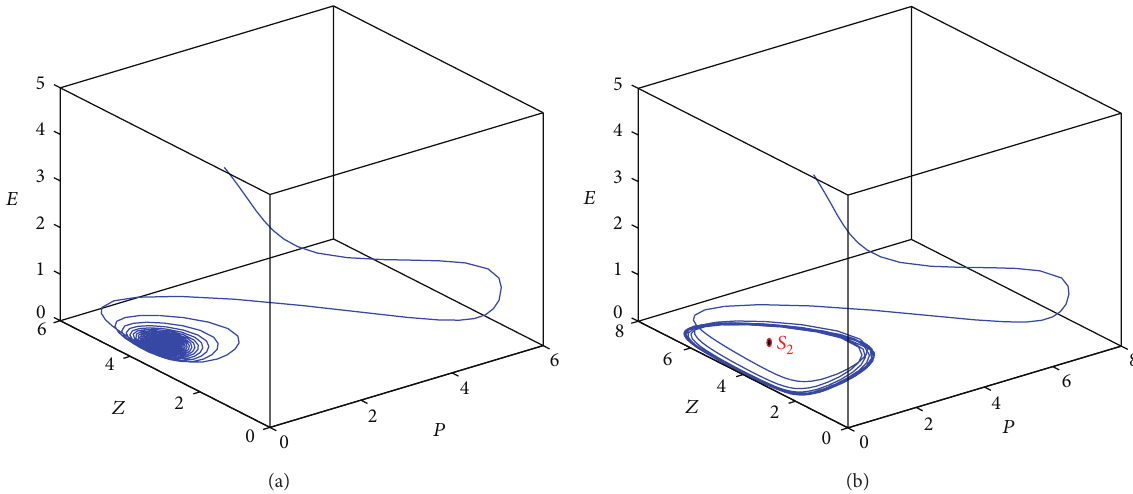
Figure 4: The stability of the equilibrium 𝑆 2 . (a) The equilibrium 𝑆 2 (0.8, 4.10, 0) is locally asymptotically stable when 𝑘 = 5.5 < 5.6 . (b) The equilibrium 𝑆 2 (0.8,4.25, 0) exhibits a Hopf bifurcation when 𝑘 = 7 > 5.6